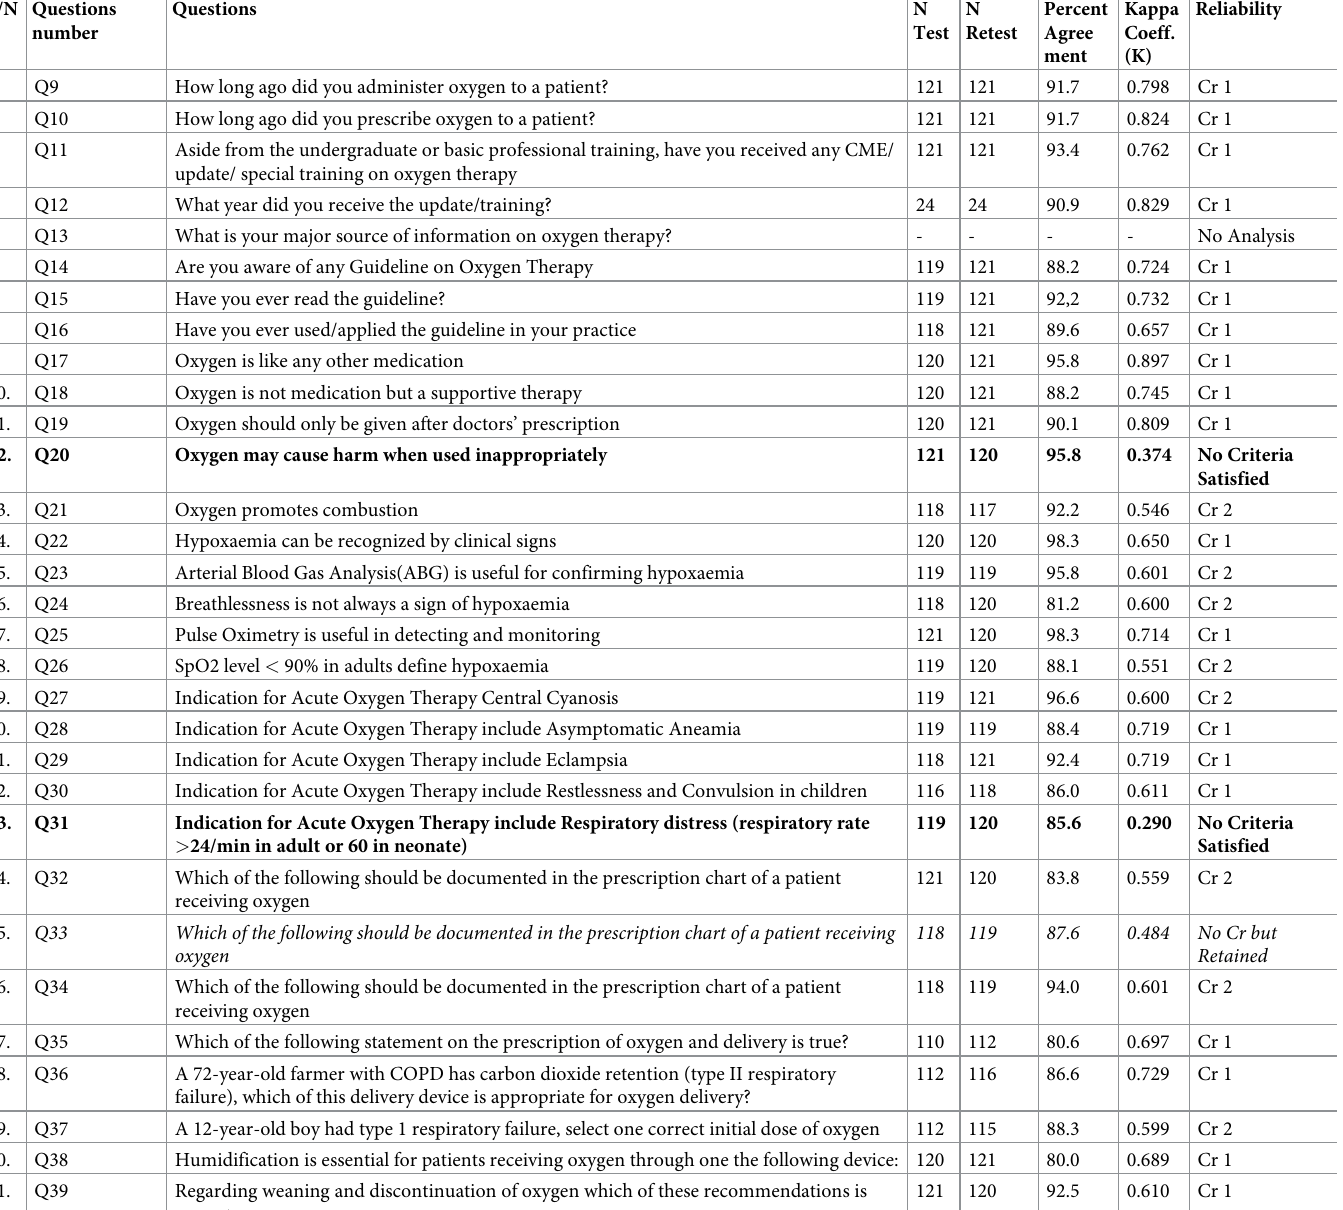
Table 3. Reliability analysis of the questions in the test-retest